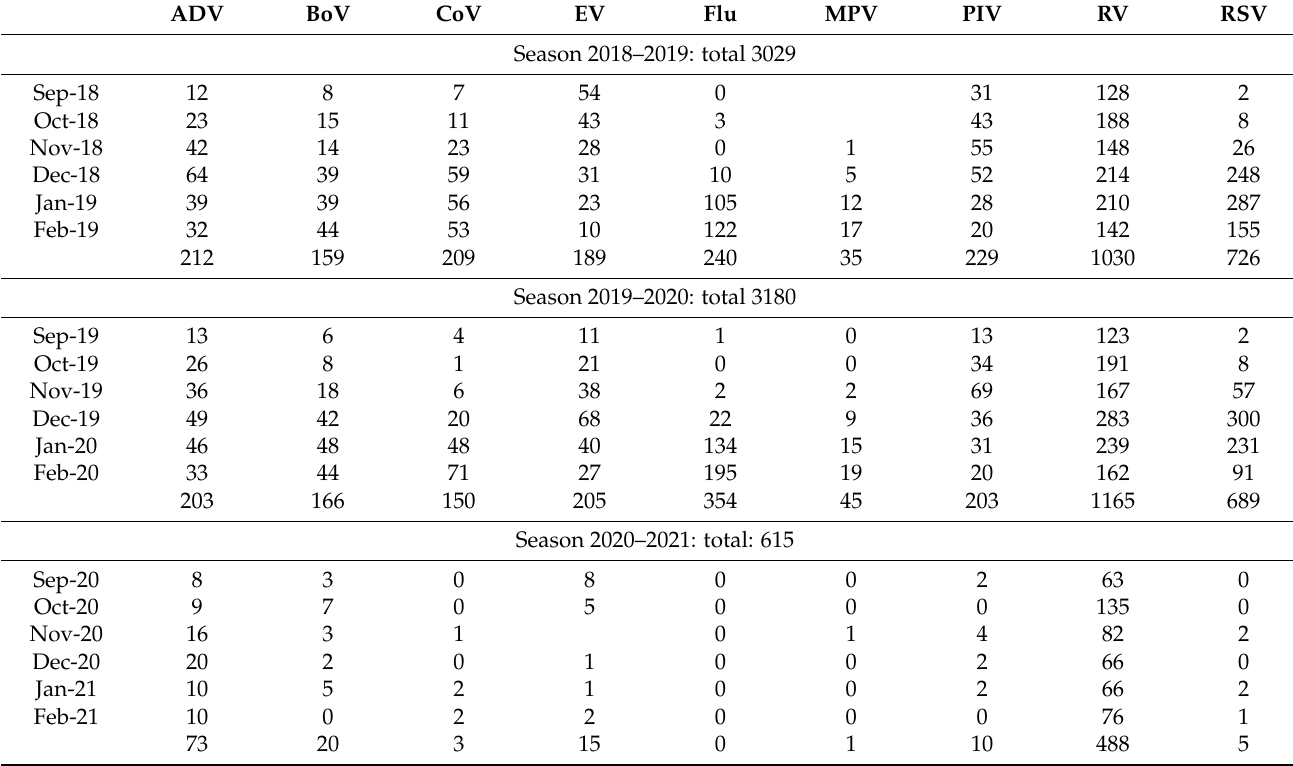
Table 1. Infections detected at Bambino Gesù Children’s Hospital.